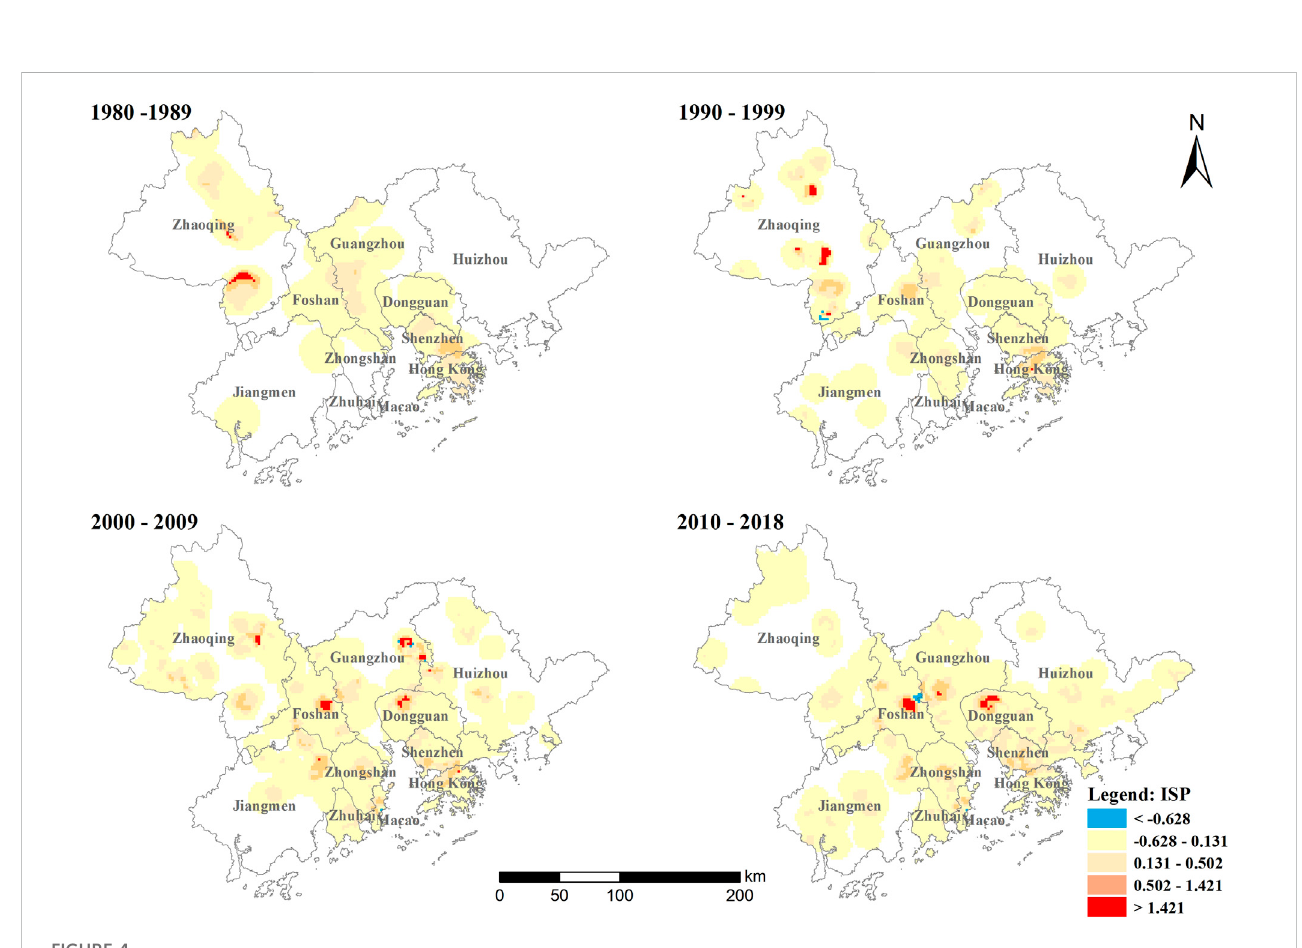
FIGURE 4 Spatial distribution of regression coef fi cients for ISP during 1980 –